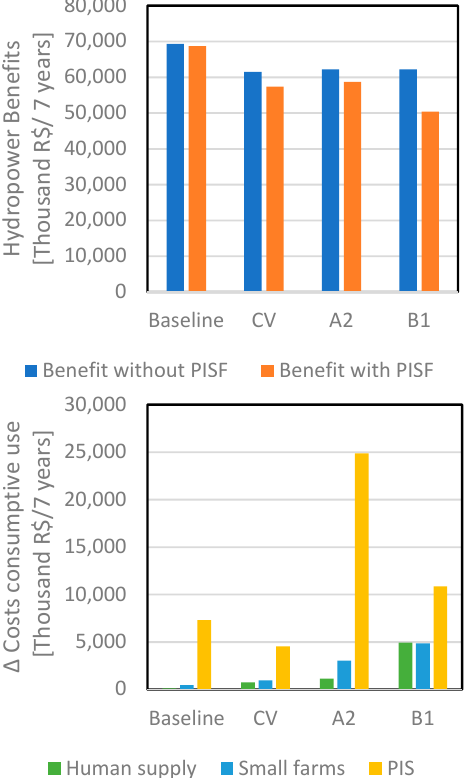
Figure 7. Difference in the benefits of hydroelectric plants and the costs of consumptive uses (Public Irrigation Schemes (PIS), small farms, human supply) in the donor basin with and without PISF (transfer project) in the optimal solution scenarios: Climate Variability (CV), Fragmentation (A2), Global Consciousness (B1).